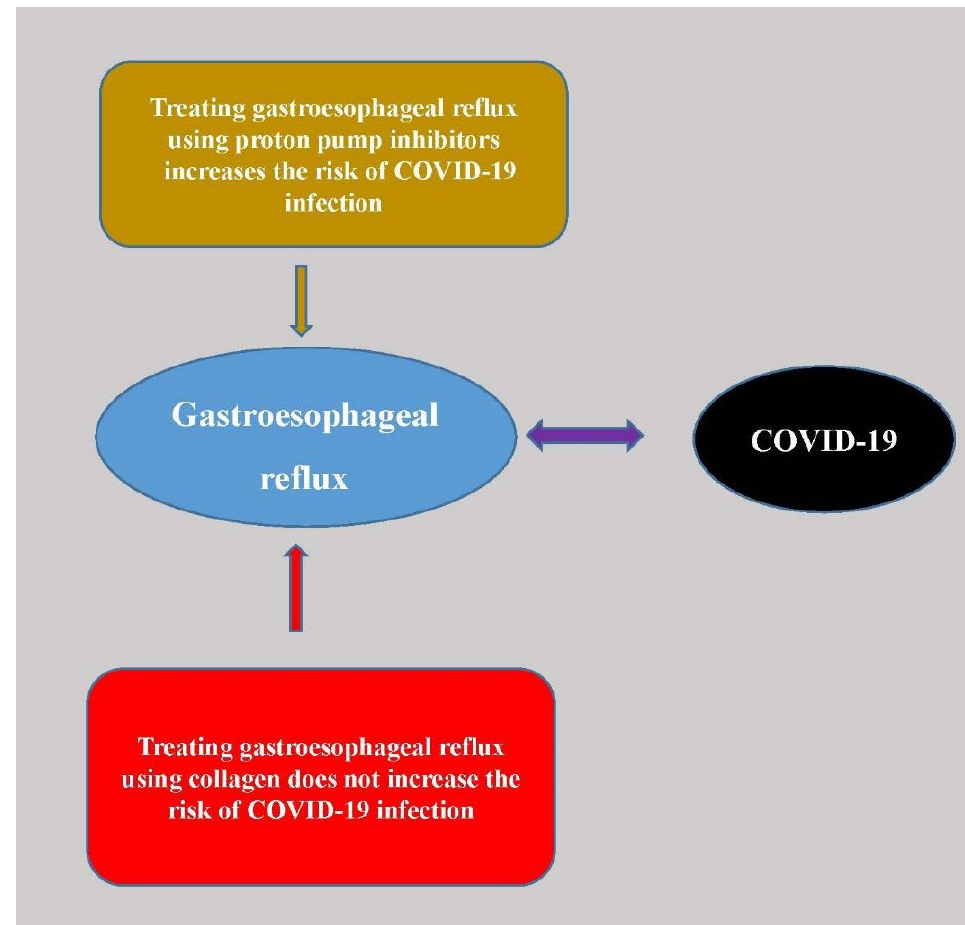
Figure 3. Using collagen to treat gastroesophageal reflux does not increase the risk of COVID-19 infection as the proton pump inhibitors drug.